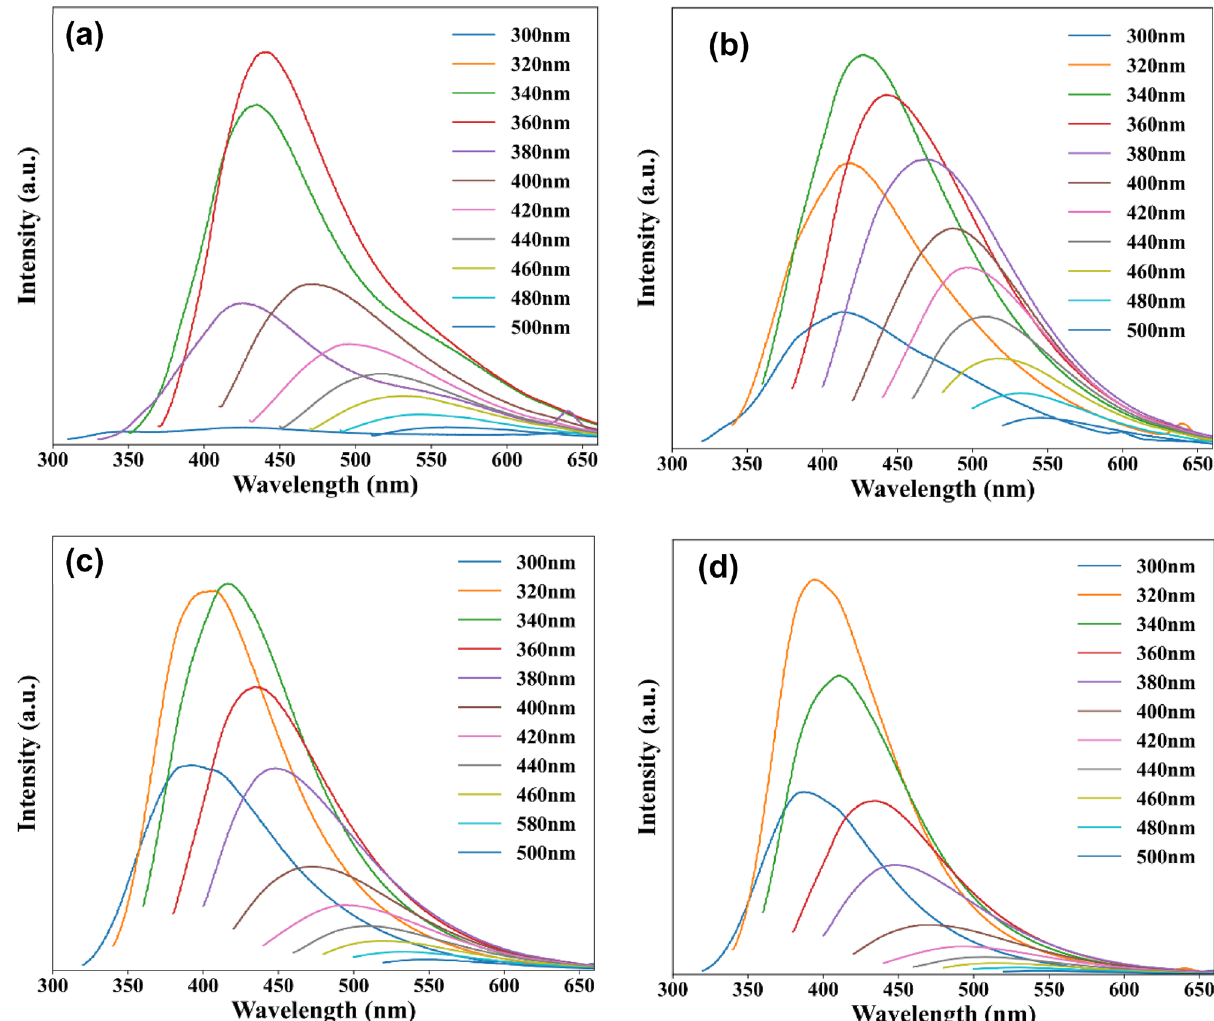
Figure 5. Photoluminescence spectra of CQD with and without nitrogen doping measured using excitation wavelengths in the range of 300 to 500 nm, (a) g-CQDs (without nitrogen doping); (b) N-0.25; (c) N-2.5, (d) N-10.